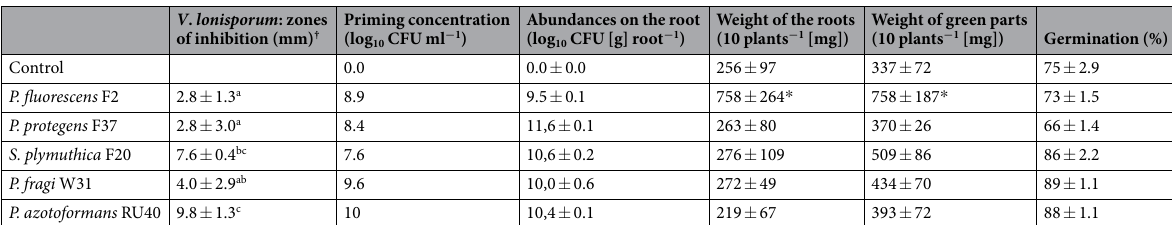
Table 2. Impact of selected strains on the B. napus seedlings grown in germination pouches. † The common letters following the mean zones of inhibition of the five independent replicates indicate non-significant difference for each strain (estimated with ANOVA Post-hoc test Tukey HSD at p = 0.05). Asterisk after the values denote for significant difference to the non-primed control plants according to the t -test for independent samples (p <